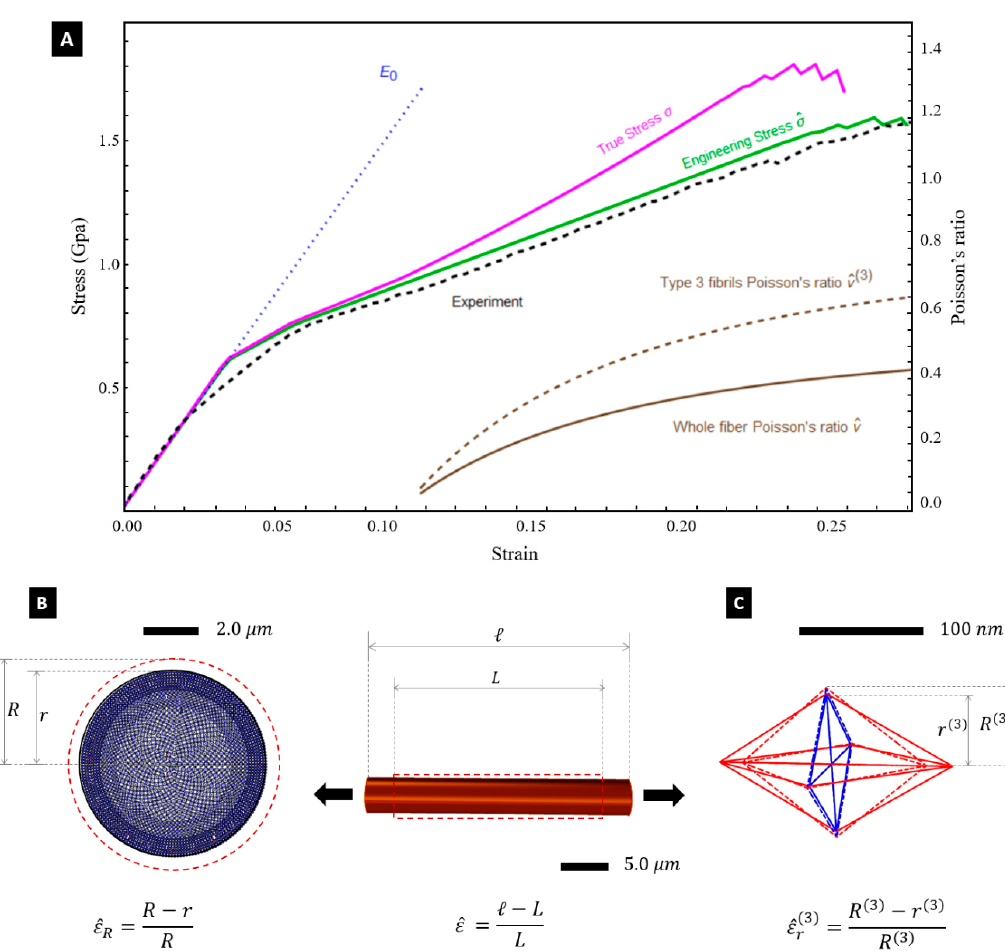
Figure 4. ( A ) Engineering ( σ(cid:3549) − ε(cid:3548) ) and true (σ − ε) stress-strain curves predicted by the tensegrity model, in comparison with the experimental results (black dashed line) for the engineering stress-strain response (exp. curve) [7]. Fluctuations of the predicted stress-strain curves at high strains (red and blue solid lines) are due to progressive fibril rupture. Secondary axis denotes the Poisson’s ratios of the whole fibre ( ν(cid:3548) ) and Type-3 fibrils ( ν(cid:3548) ((cid:2871)) ). ( B , C ) Different views of the deformed configurations of the whole fibre ( B ), and a Type-3 fibril ( C ) at 𝜀̂ = 0.265 .